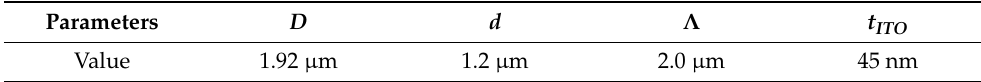
Table 1. Optimized geometric parameters for the sensor.